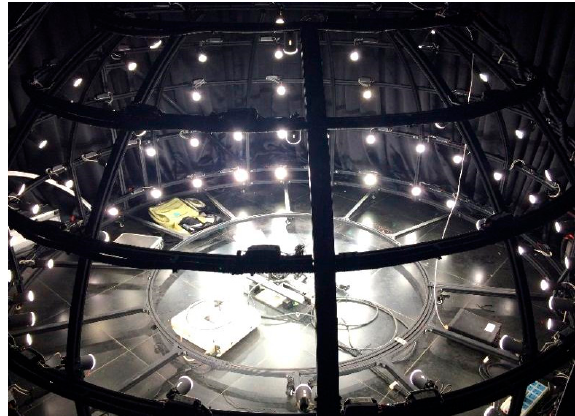
Figure 5. The working status of the skylight simulator.